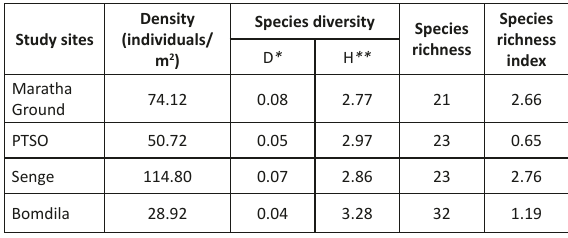
Table 3. Number of Primula species along with altitudinal gradient in the study area. Altitude (m) Name of the species